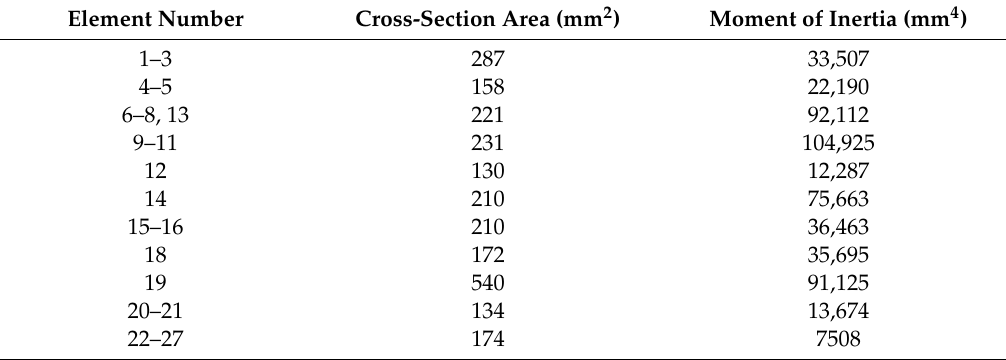
Table 3. Cross-section parameters of the bicycle frame (reprinted from [23], with the permission of AIP Publishing).